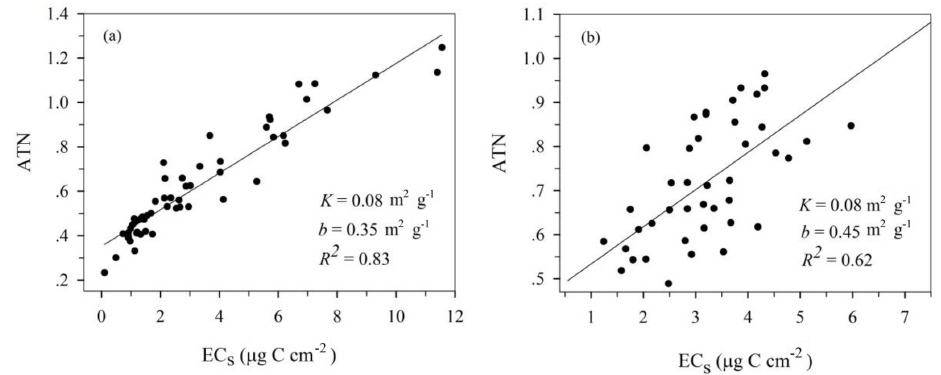
Figure 3. Dependence of optical attenuation (ATN) detected at 632nm on the EC loading (EC s ) for (a) the Mt. Yulong sampling site and (b) the GHZ sampling site. Results of linear regression are displayed with K as the slope and b as the intercept.